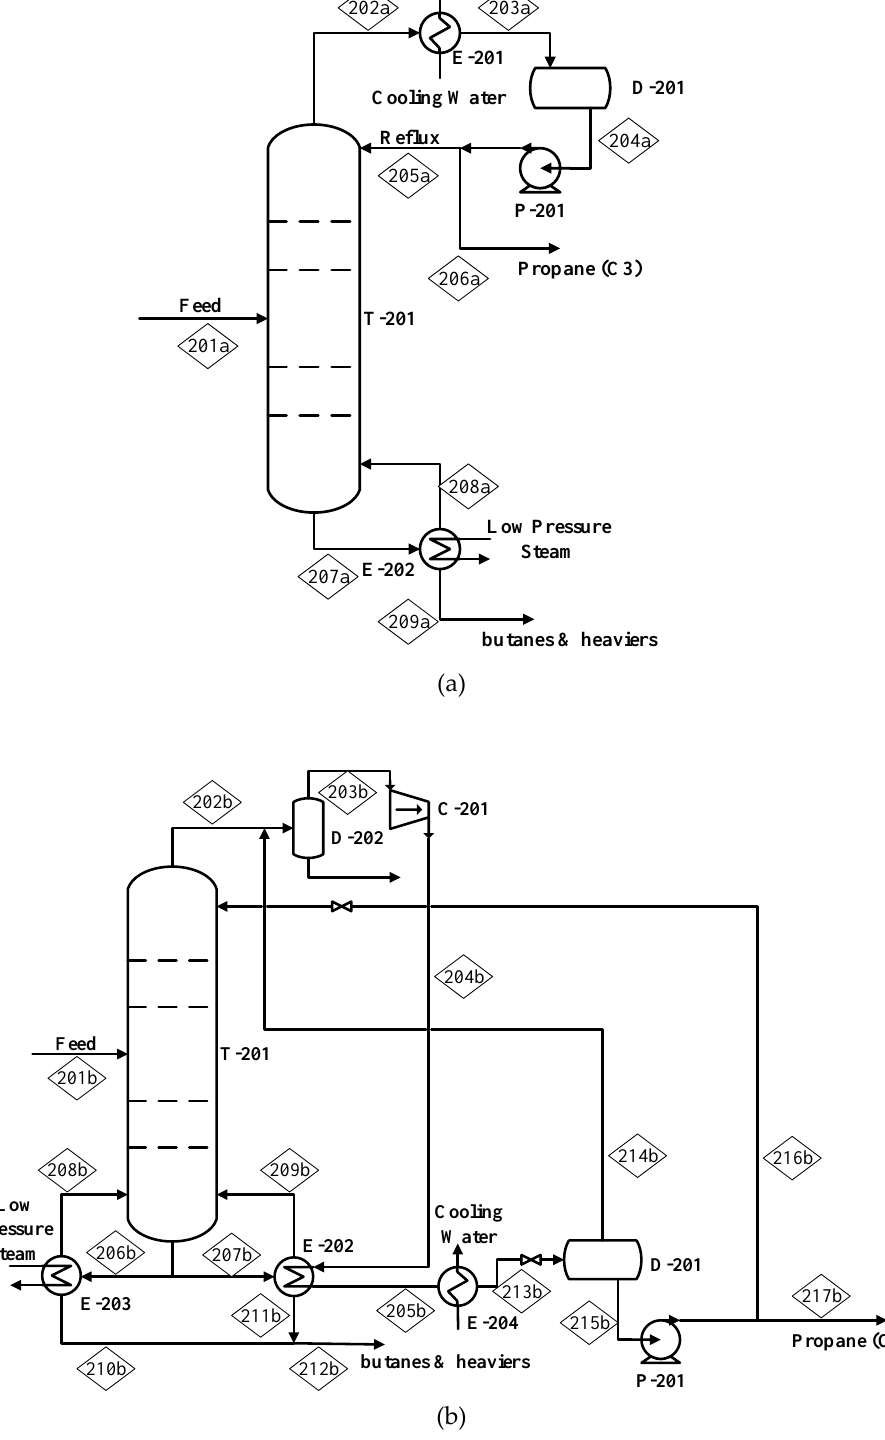
Figure 2. Process flow diagram for the de-propanizer in ( a ) conventional and ( b ) heat pump-assisted distillation.